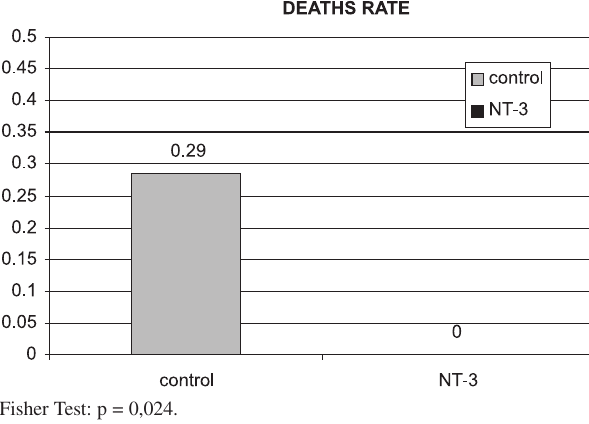
This difference was statistically significant ( P =